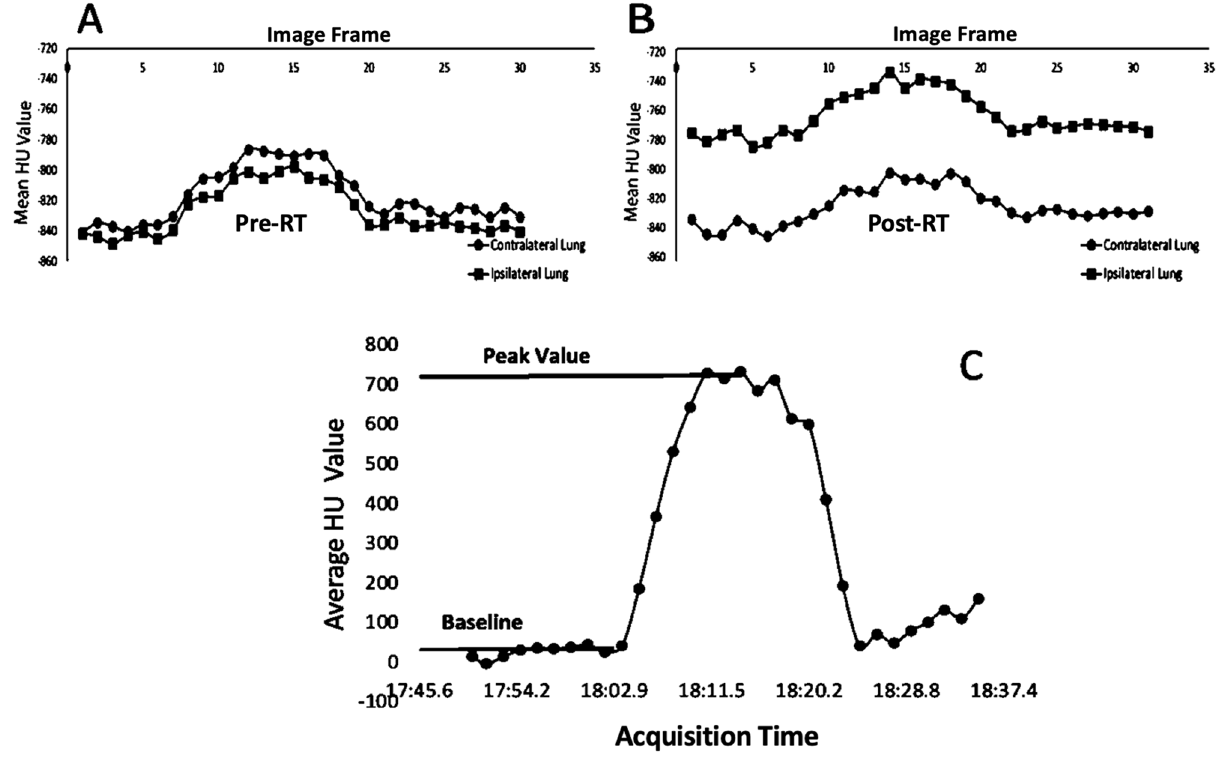
Figure 2. ( A ) Plot of the mean HU value of the lung parenchyma pre-RT. ( B ) Plot of the mean HU value of the lung parenchyma 3 months post-RT in a typical WMS swine and Each data point represents the average HU value in the lung parenchyma in a single acquisition (image frame) over the time trace of the dynamic contrast- enhanced 4DCT. ( C ) Plot of the mean HU value of the vessels showing the two measurements obtained. The two measurements are the baseline HU value (HU value before contrast injection) and the peak HU value (the HU value at the timepoint in the 4DCT where the contrast concentration was at it’s maximum value inside the